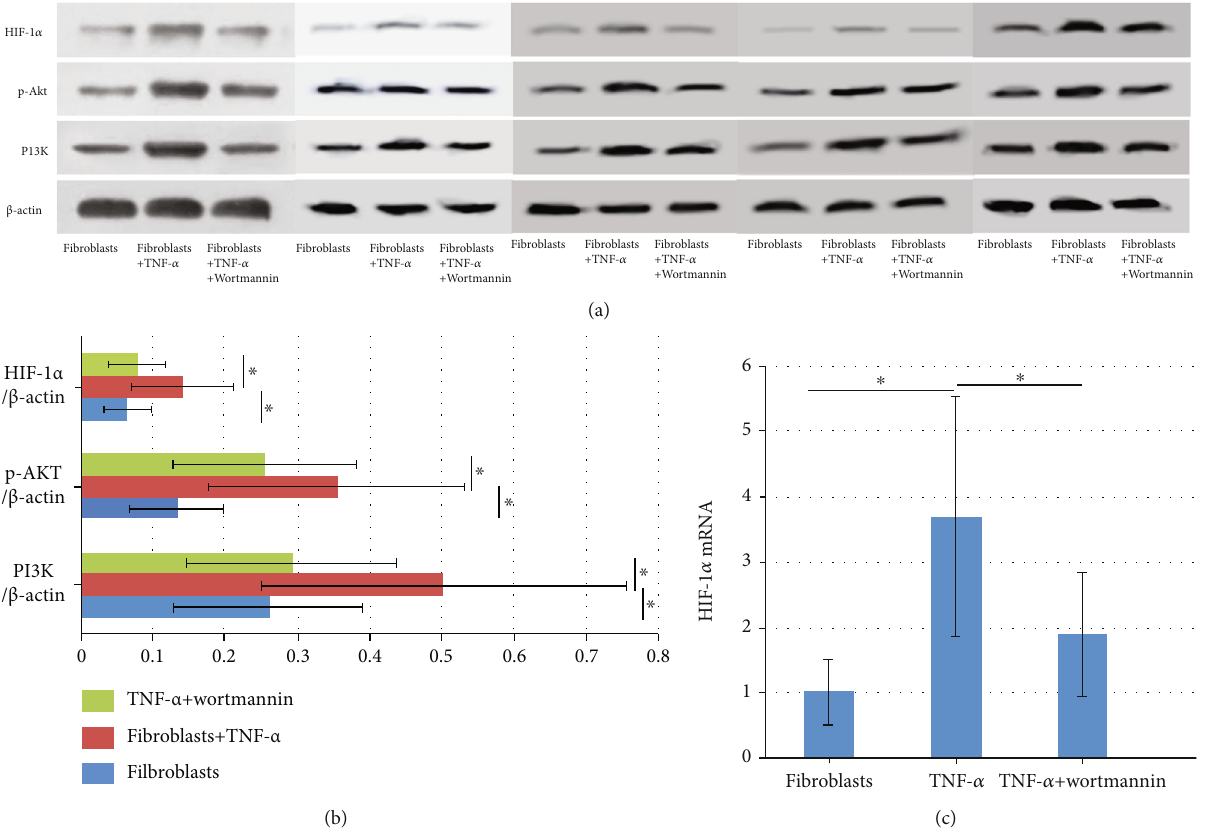
Figure 4: The expressions of the PI3K/Akt/HIF-1 α pathway in fi broblasts from nasal polyps. (a) The protein levels of HIF-1 α , p-Akt, and PI3K in nasal polyp fi broblasts were detected by the WB method. (b) After TNF- α stimulation, the HIF-1 α , p-Akt, and PI3K protein levels were signi fi cantly increased in nasal polyp fi broblasts. P = 0 : 032, 0 : 032, and0 : 032 . After treatment with Wortmannin, the HIF-1 α , p-Akt, and PI3K protein levels were signi fi cantly decreased in nasal polyp fi broblasts. P = 0 : 032, 0 : 008, and 0 : 032 . (c) Expression of HIF-1 α mRNA in fi broblasts of nasal polyps. After TNF- α stimulation, the HIF-1 α mRNA level was signi fi cantly increased in nasal polyp fi broblasts. P = 0 : 001 . After treatment with Wortmannin, the HIF-1 α mRNA level was signi fi cantly reduced in nasal polyp fi broblasts. P = 0 : 001 . ∗ P < 0 : 05 . Table 2: The levels of HIF-1 α , p-Akt, and PI3K protein in nasal polyp fi broblasts. β